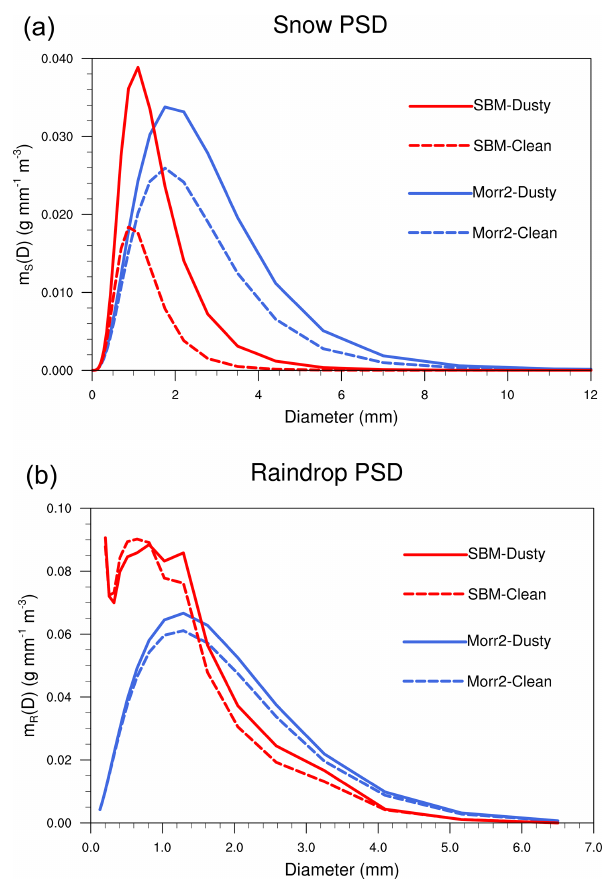
Figure 8. Particle mass spectrum size distributions of the (a) snow particles and (b) raindrops from SBM-Clean (dashed red line) and Dusty (solid red line) and Morr2-Clean (dashed blue line) and Dusty (solid blue line) runs averaged over all the precipitation grids in the High-Pcp area during